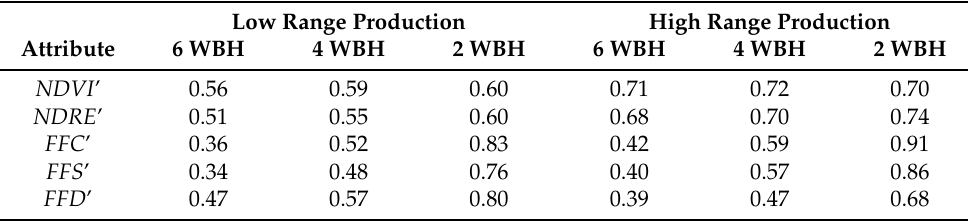
Table 5. Mean value of accumulative attributes for low (124–141 (Ton/ha)) and high 176–193 (Ton/ha) ranges of production, for 6, 4, and 2